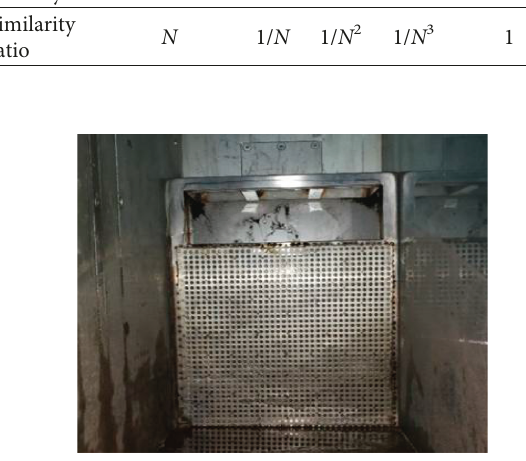
Figure 2: The water box.